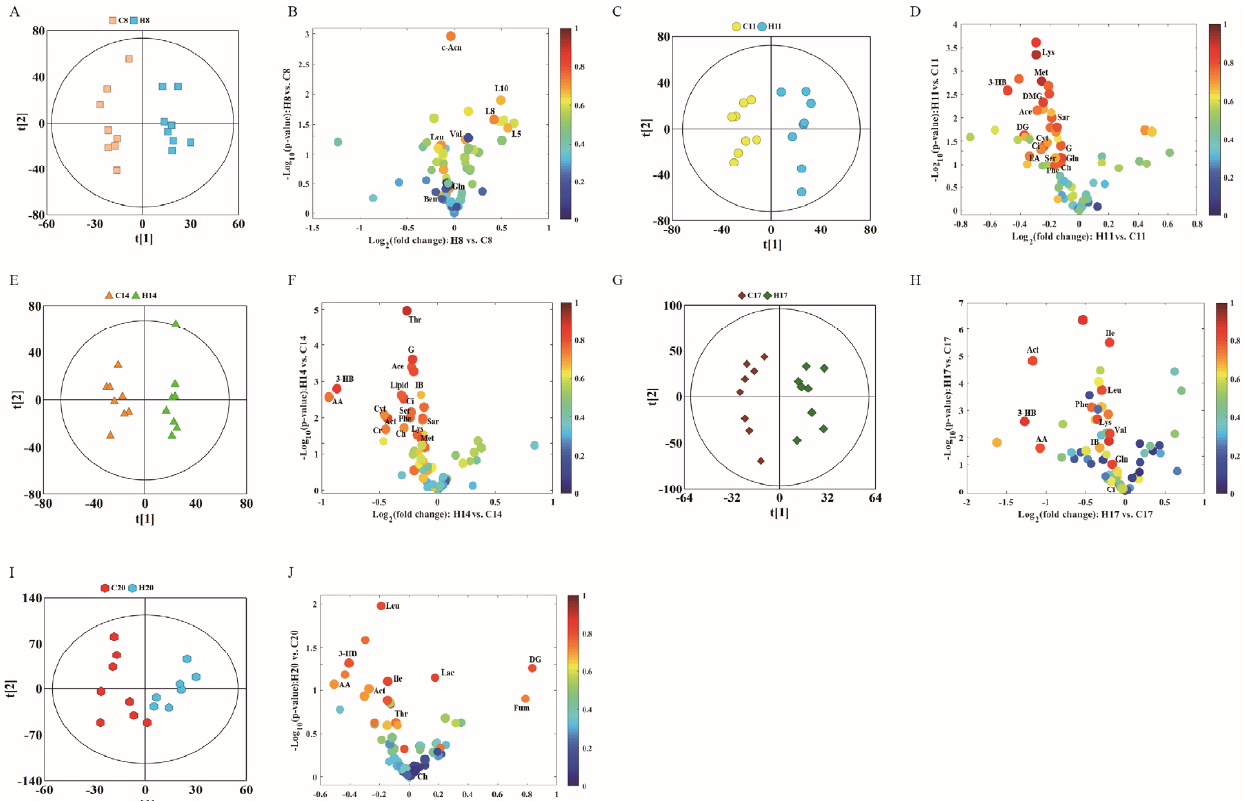
Figure 3. OPLS-DA score plots ( left panel) derived from 1 H NMR spectra of plasma samples and corresponding volcano plots ( right panels) obtained from different groups and cross validation ( lower panel) by permutation test ( n = 200). ( A , B ) D8; ( C , D ) D11; ( E , F ) D14; ( G , H ) D17; and ( I , J ) D20. The color map shows the significance of metabolites variations between the two classes. Peaks in the positive direction indicate metabolites that are more abundant in the groups in the positive direction of first principal component. Consequently, metabolites that are more abundant in the groups in the negative direction of first primary component are presented as peaks in the negative direction.